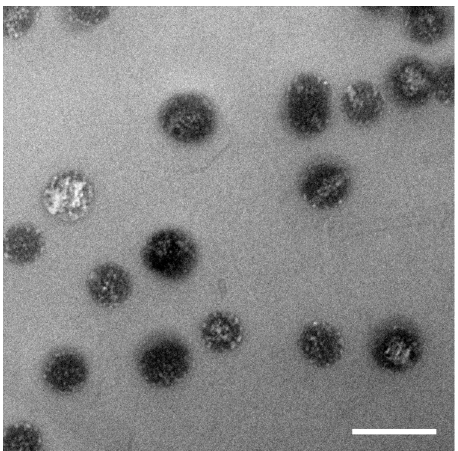
Figure 3. TEmicrograph of SiPN-1. Scale bar is 200 nm. Each particle has a darker core and a rough surface resulting from the dried microgel shell.